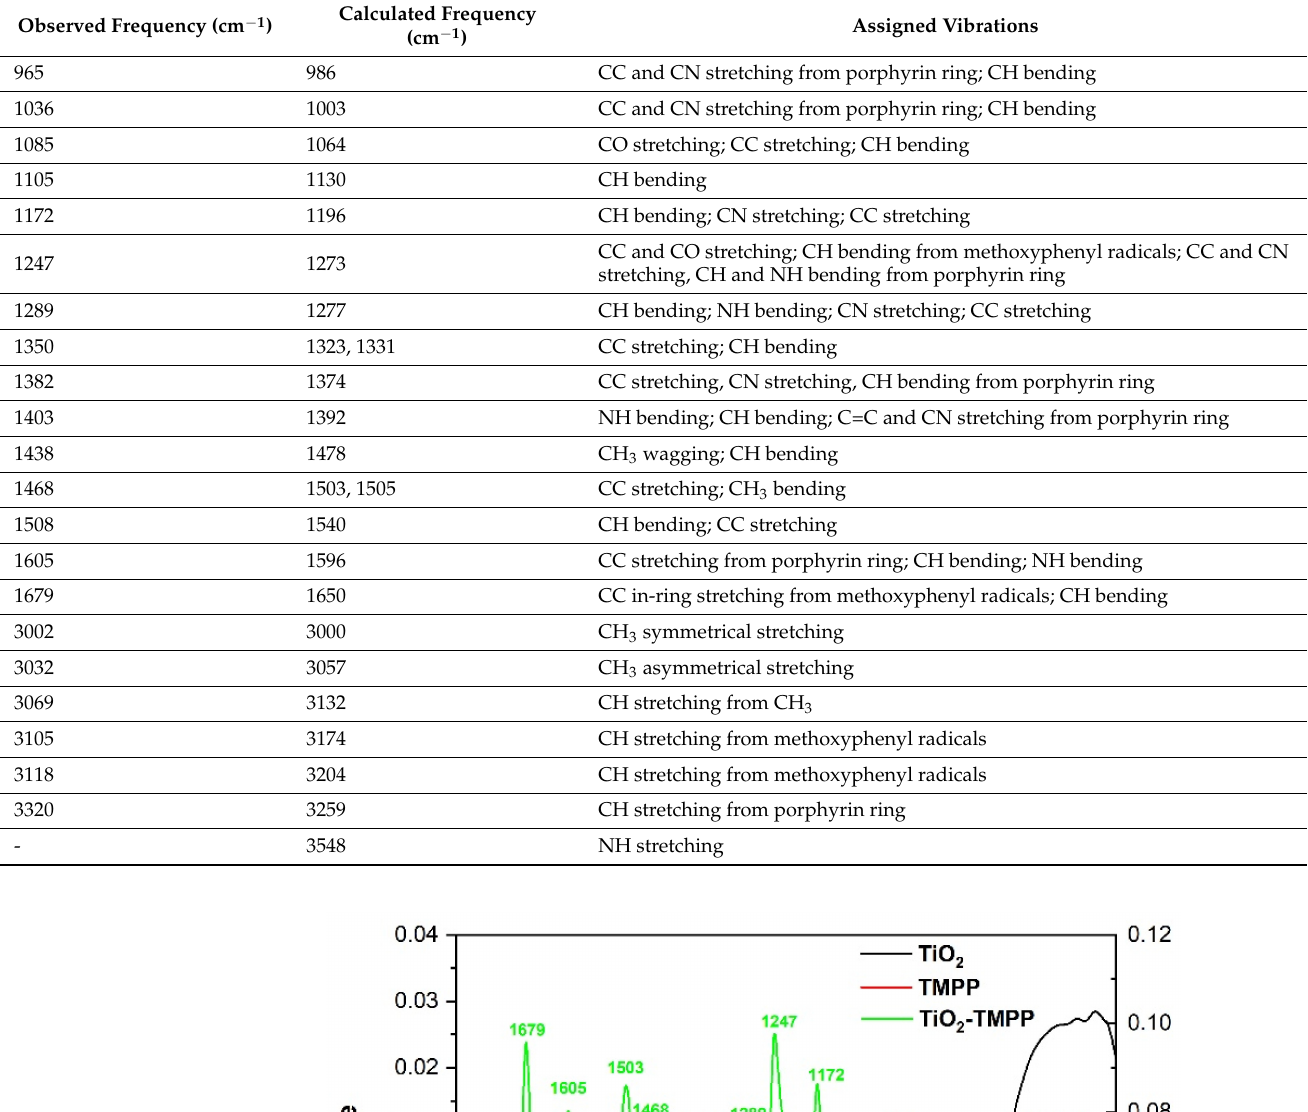
Table 4. Experimental and calculated frequencies for TMPP.